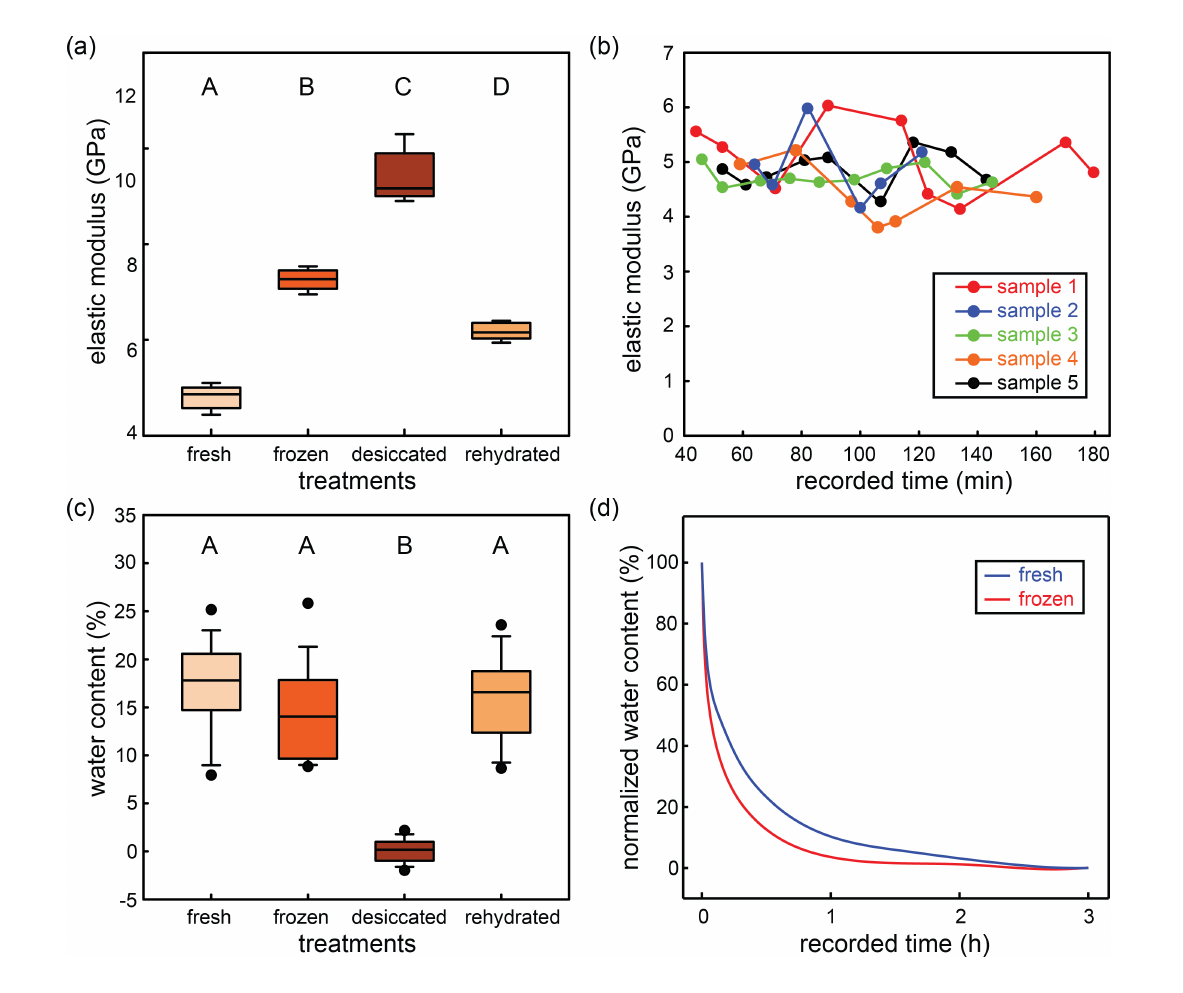
Figure 2: Elastic modulus and water content of specimens in different treatment groups. (a) The elastic moduli of fresh ( n = 5), frozen ( n = 5), desic- cated ( n = 5), and rehydrated ( n = 5) hind tibiae are 4.8 ± 0.2, 7.3 ± 0.2, 9.4 ± 0.5, and 6.2 ± 0.2 GPa, respectively. Significant differences were deter- mined via Holm–Sidak one-way ANOVA. Different capital letters indicate significant differences ( P < 0.001). (b) Elastic modulus of fresh tibiae as a function of the recorded time. Different samples are presented in different colors. Each data point represents the elastic modulus obtained from a distinct indentation site. (c) Water contents of fresh ( n = 15), frozen ( n = 15), desiccated ( n = 15), and rehydrated ( n = 15) hind tibiae. Significant differ- ences were determined via Kruskal–Wallis one-way ANOVA on ranks. Different capital letters indicate significant differences ( P < 0.05). (d) Water contents of fresh ( n = 3) and frozen tibiae ( n = 3) as function of the